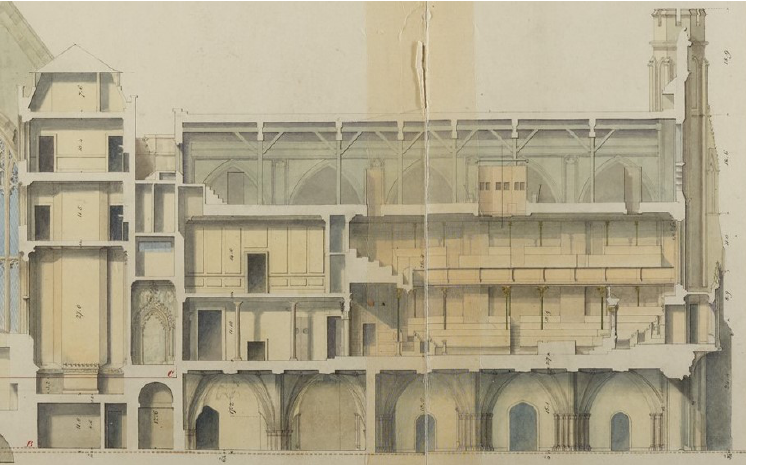
Figure 2. Section from west to east, showing the storeys of the House of Commons spaces, August 1834